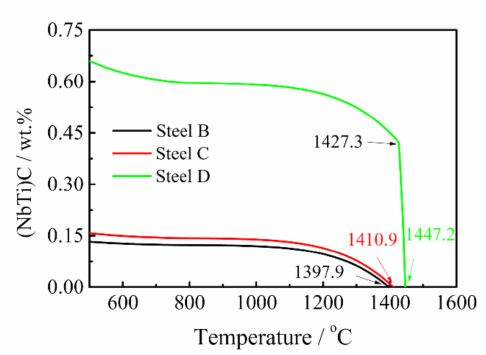
Figure 6. Different additions of (NbTi)C particles dissolution behavior in cast steels using Thermo- Calc software based on the TCFE 7